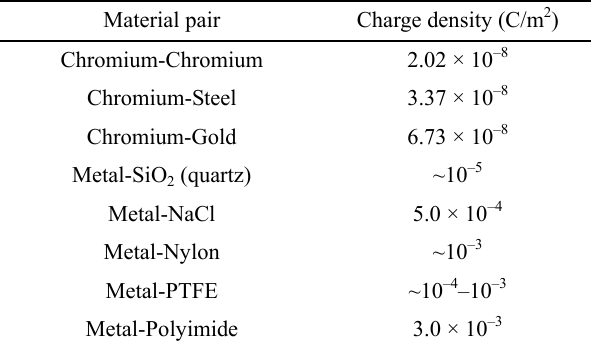
Table 2 Surface charge density after triboelectric charge